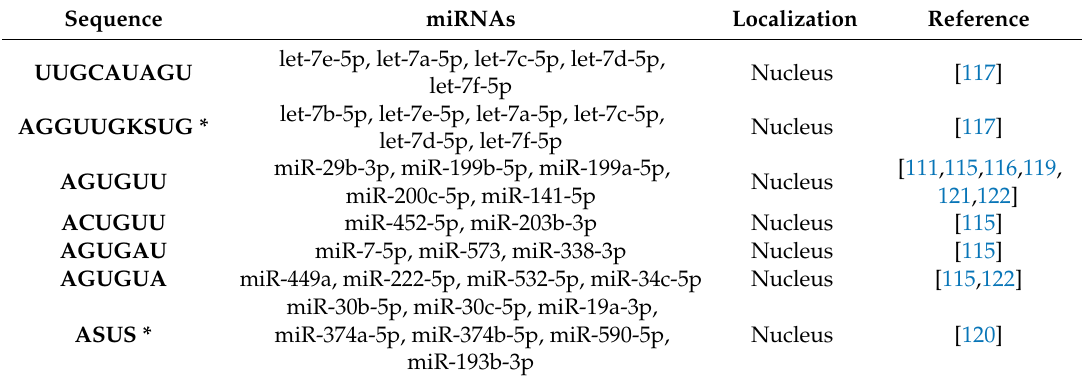
Table 1. Nuclear localization sequences in